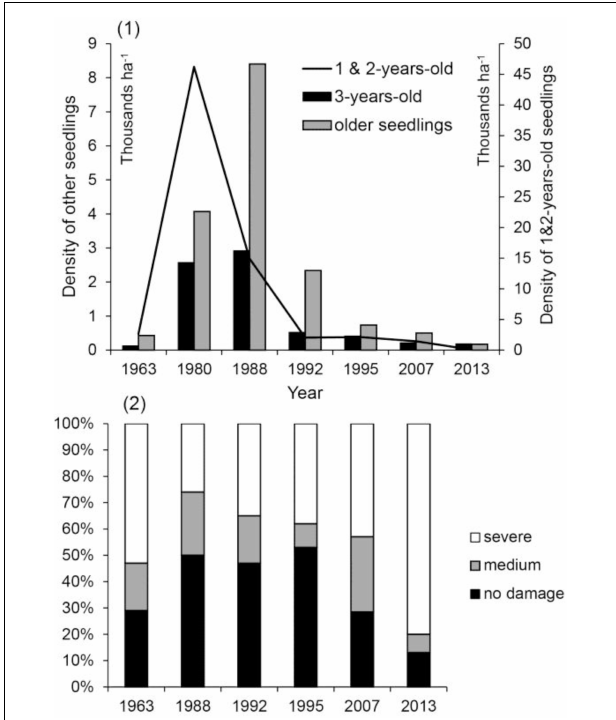
FIGURE 4 | (1) Dynamics of silver fir regeneration density by age class and (2) browsing damage to small silver fir seedlings by year.